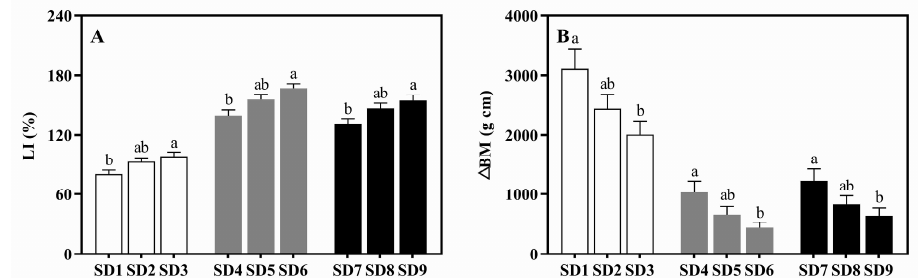
Figure 3. Comparison of the LI ( A ) and △ BM ( B ) for the three sowing dates in each year. LI, lodging index; △ BM, the external force that the basal second internode could withstand. All abbreviations imply the same below as well. Vertical bars indicate standard errors ( ± ), n = 12 for each SD. Different lowercase letters on the bars indicate significant differences determined by the Tukey test at 5% probability level . Table 2. The lodging index of twelve indica rice cultivars on all the sowing dates across two locations and three years.